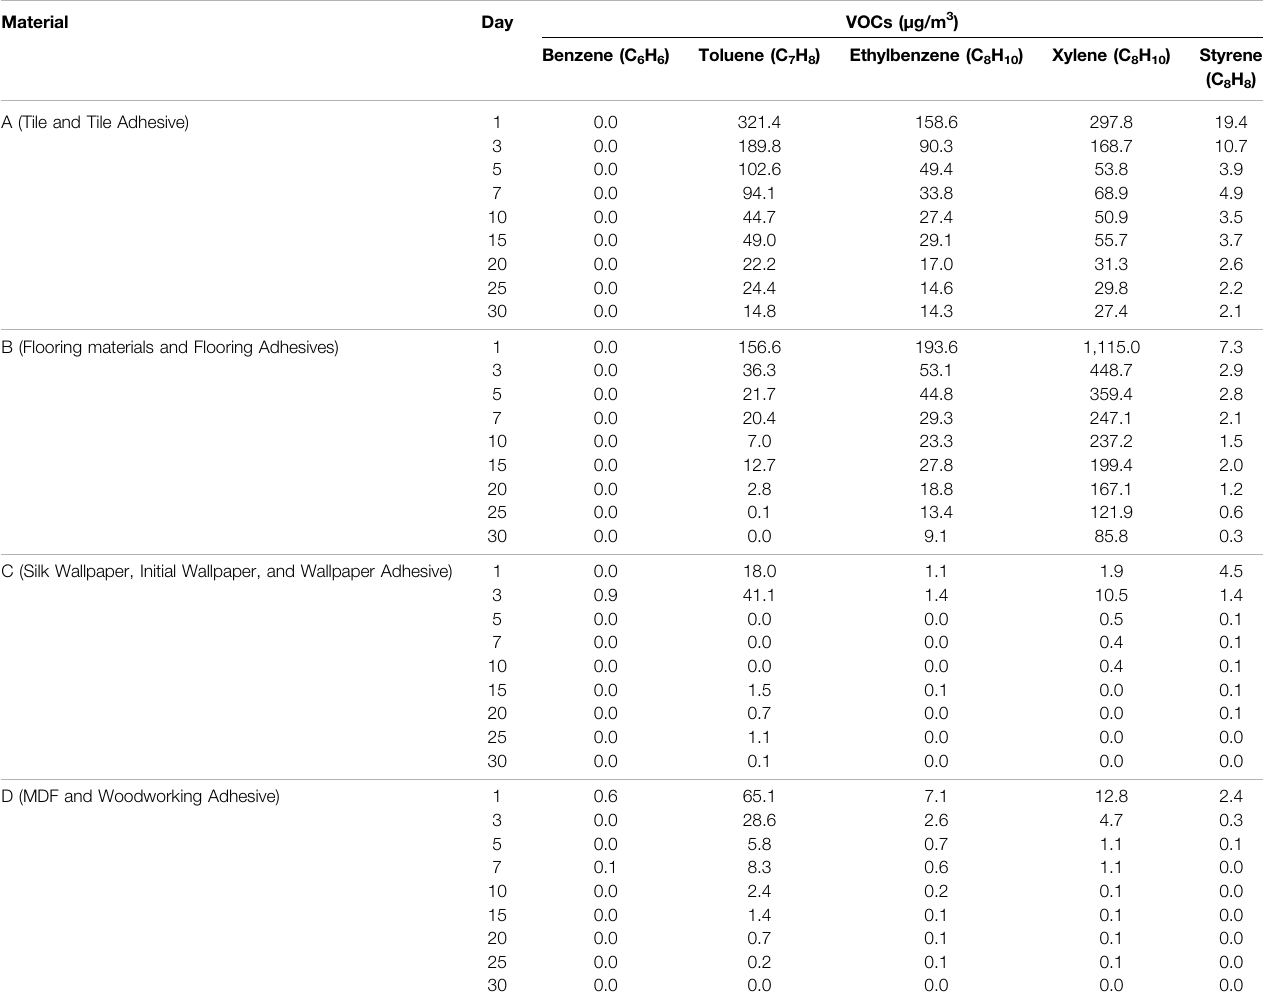
TABLE 9 | Amount of indoor air pollutants from fi nishing material